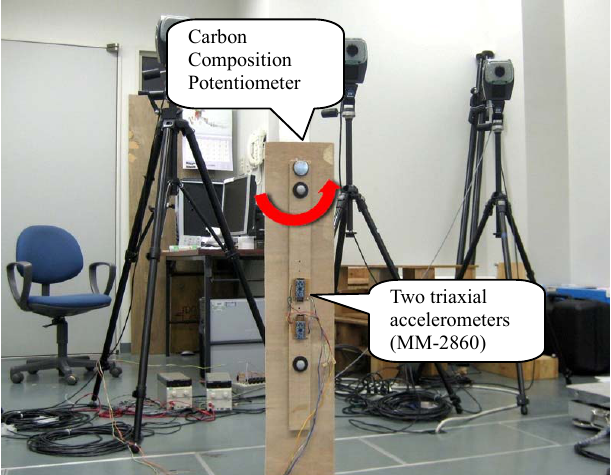
Fig.8 A simple device for estimating the rotation angles in a 2D frame using two